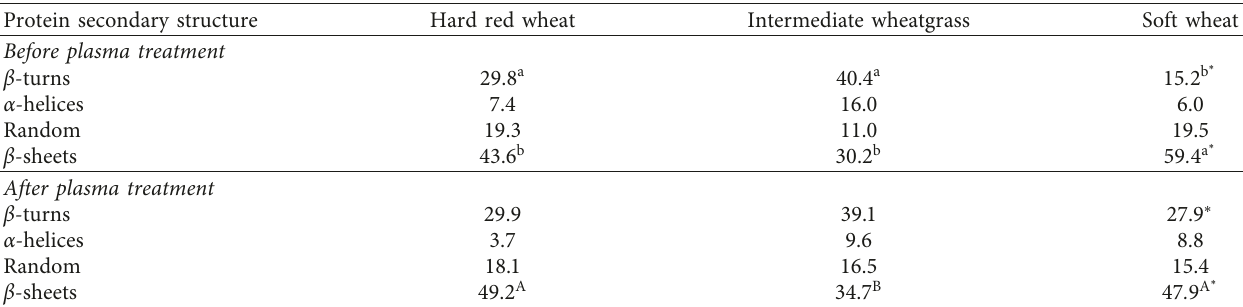
Table 2: Proportional contribution of different secondary structures to overall protein secondary structure in hard red wheat, soft wheat, and intermediate wheatgrass before and after plasma treatment.